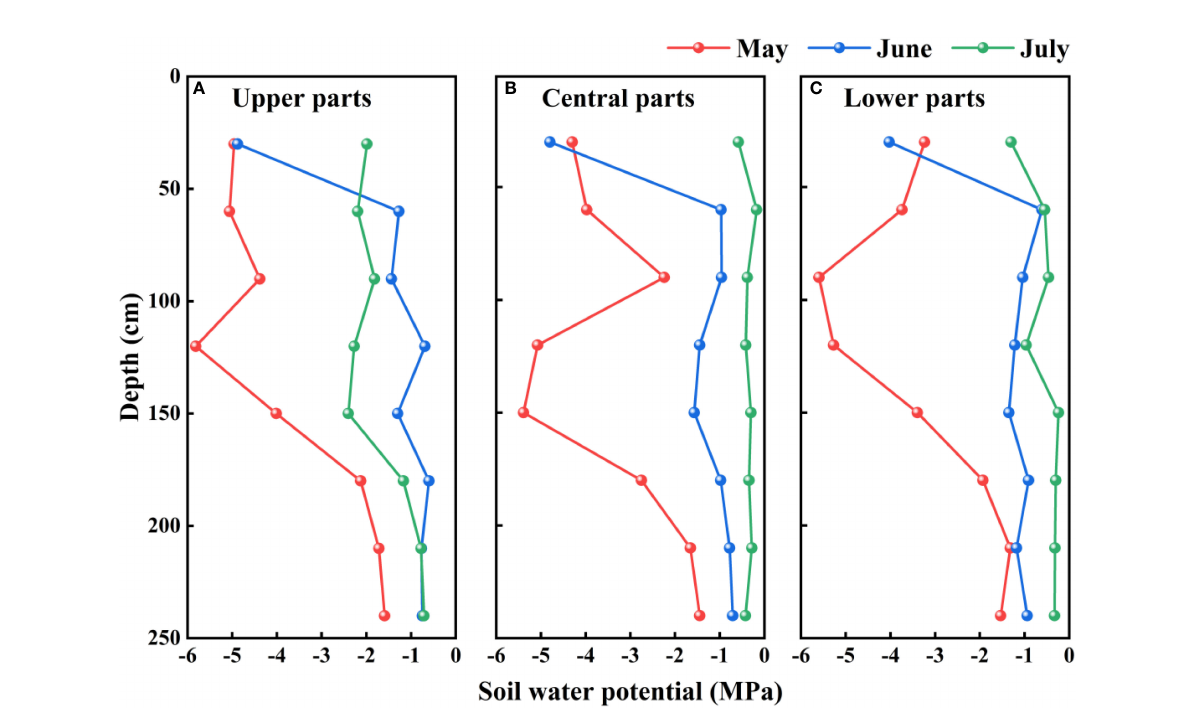
FIGURE 7 Vertical distribution of the soil water potentials on mega-dunes in the Badain Jaran Desert during the 2020 growth season. (A – C) present data for the upper, central, and lower parts of mega-dunes,